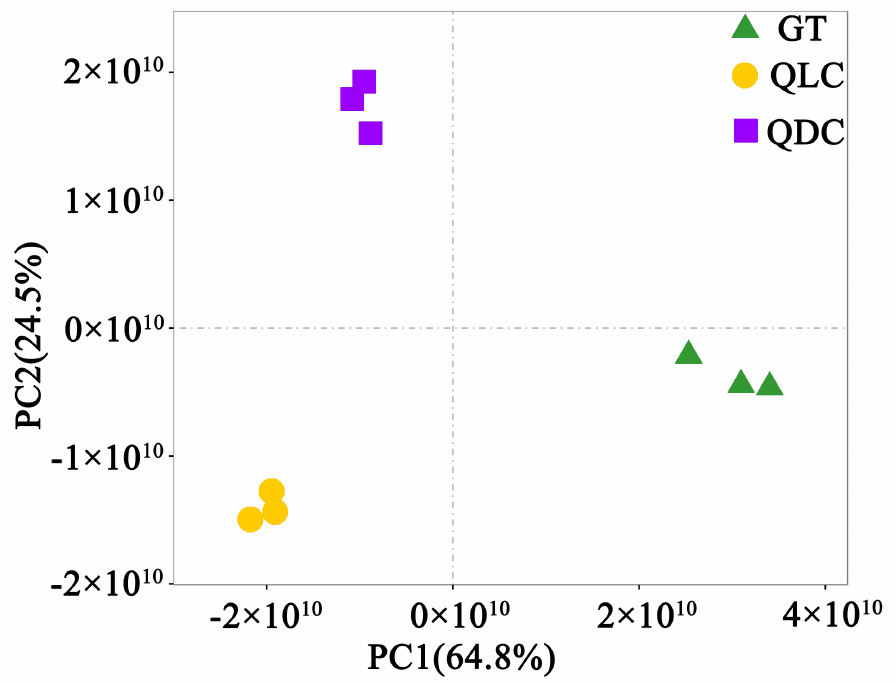
Figure 2. A PCA score plot derived from the UPLC-Q-Exactive Orbitrap-MS datasets of the three tea